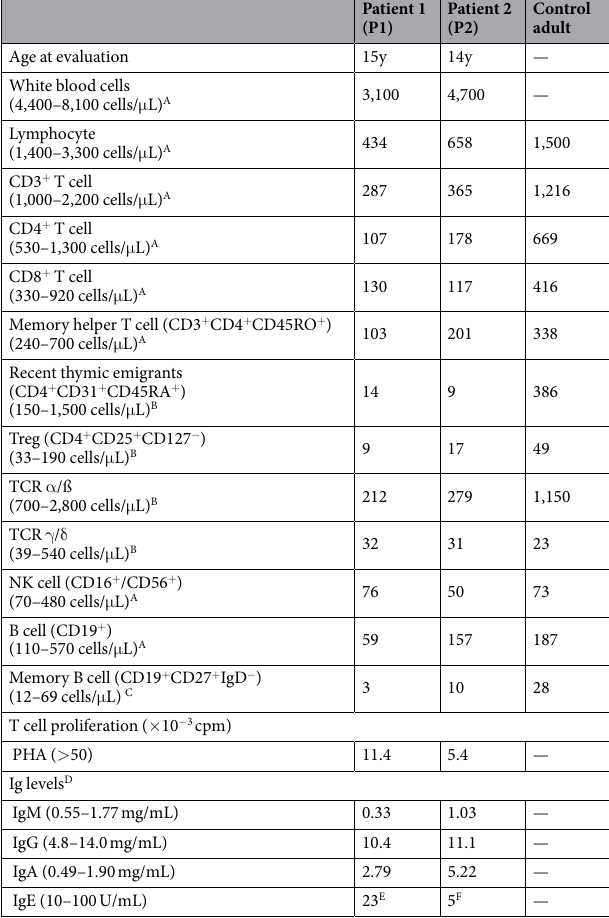
— Table 2. Immunological features of patients P1 and P2. A Age-matched normal values for lymphocyte counts according to Journal of Allergy and Clinical Immunol 2003; 112:973-80 49 , B Scandinavian Journal of Immunology 2012; 75:436-44 50 , C Immunity, Inflammation and Disease 2014; 2:131-40 51 , D Blood 2012; 119:3458-68 26 . E Analyzed at 16 years of age. F Analyzed at 16 years of